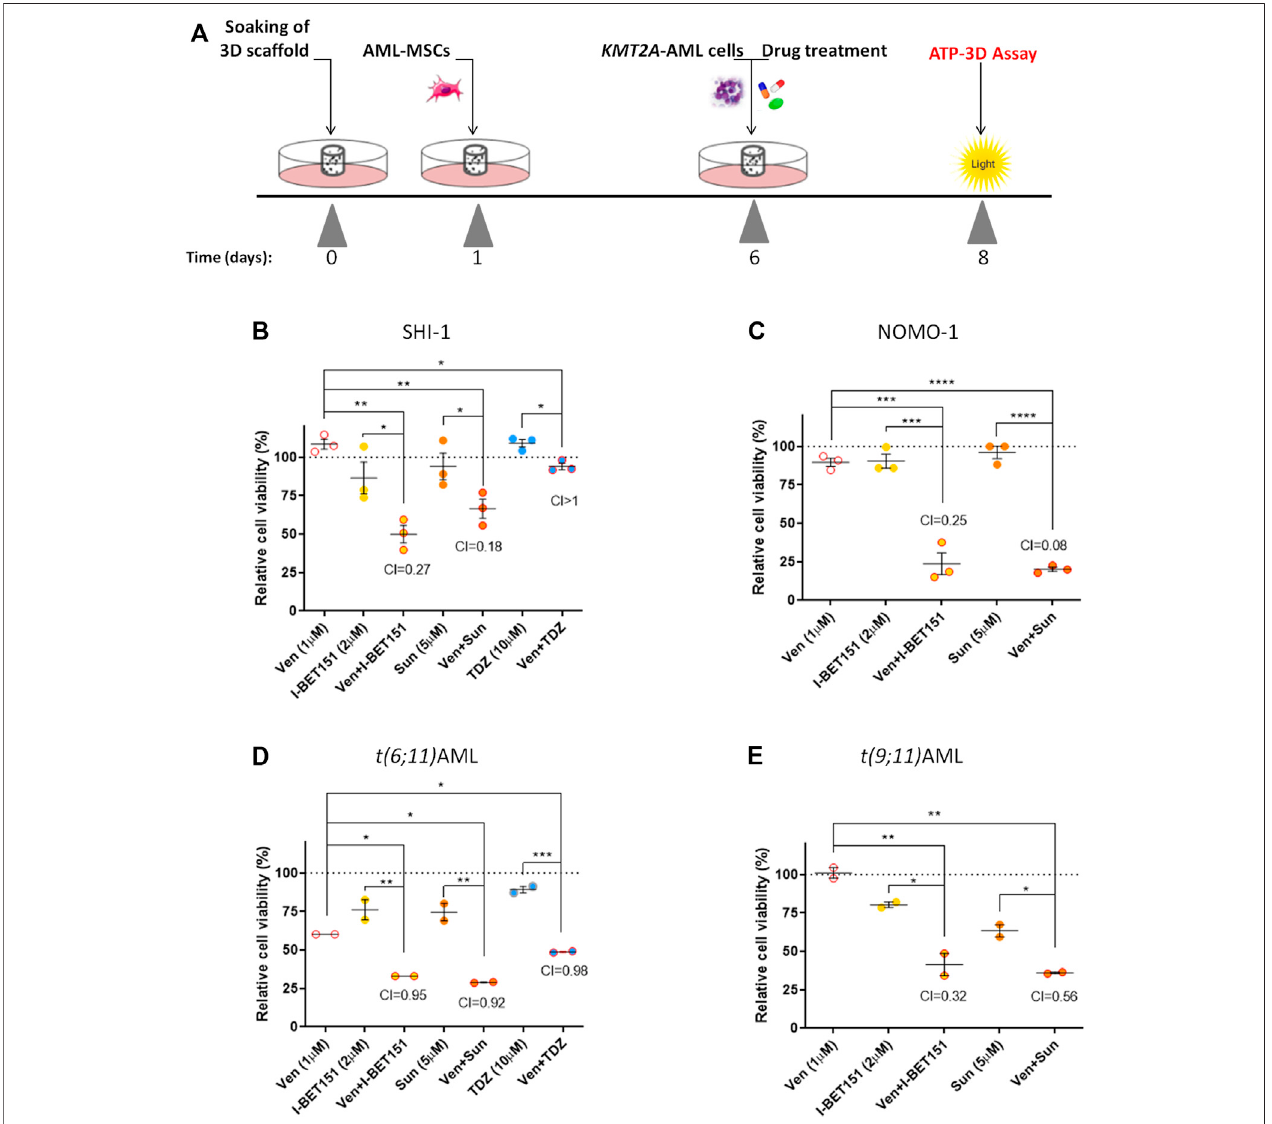
FIGURE6| Combinationtreatmentsin3Dmodel.( A )Schemeofthe invitro 3Dculturesetupprocedure:hydroxyapatite/collagenscaffoldswereallowedtosoakfor 24 h,then seeded withacute myeloid leukemia(AML)-MSCs ( t =1),and cultured for afurther 5dayspriortoadding ofKMT2A-rearranged AML cellsand performingthe drugtreatment( t =6). Cellviabilitywasevaluatedin the3D system at 48 h after treatment( t =8) byATP 3Dassay.( B – D )Cell viability of3D system analyzed at 48 hafter drugtreatmentwithvenetoclax(1 μ M),I-BET151(2 μ M),sunitinib(5 µM),andthioridazine(10 μ M)normalizedtotherespectivecontrols(dimethylsulfoxide; n =3)in SHI-1 and NOMO-1 cell lines ( B , C ) and AML primary samples ( D , E ). CI, combination index; synergy when CI < 1. ANOVA test was performed by applying Bonferroni correction for multiple statistical hypotheses testing. * p < 0.05; ** p < 0.01; *** p < 0.001; **** p < 0.0001.